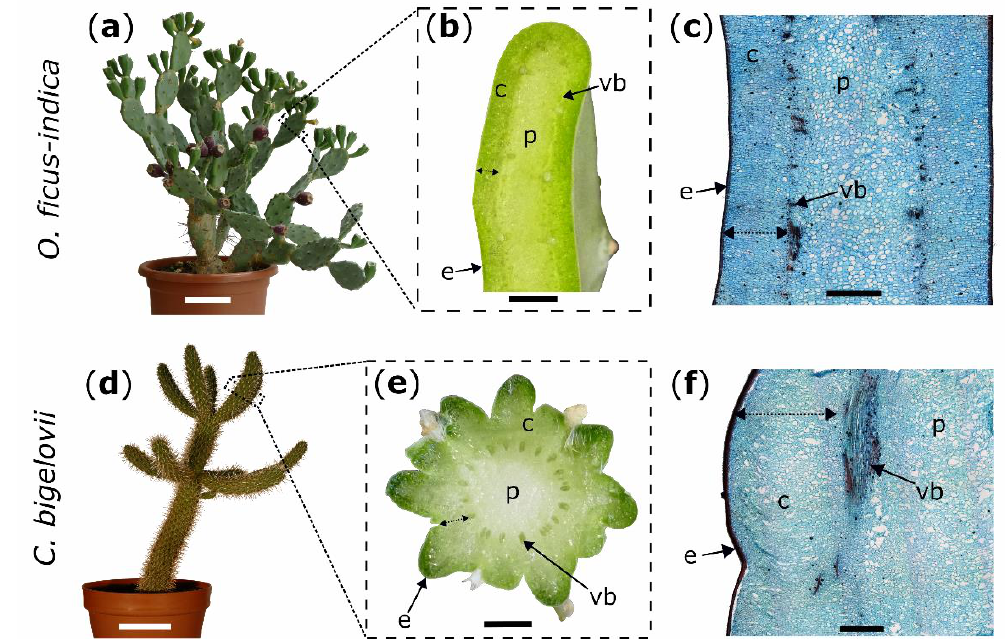
Figure 5. Experimental plants (left images) with macroscopic transverse sections (middle images) and microscopic tangential sections stained with safranin O and Astra blue (right images); Opuntia ficus-indica: ( a – c ); Cylindropuntia bigelovii : ( d–f ). Double arrows mark the measured cortex depth ( b , e ) and the intended depth of the ring incisions through the cortex down to the vascular bundles ( c , f ). c: